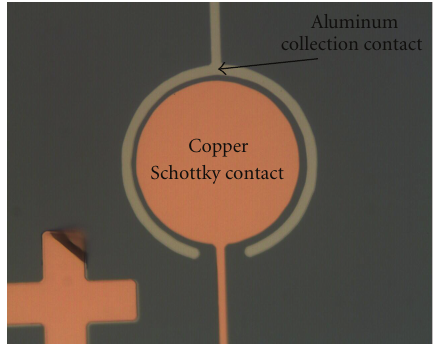
Figure 3: Top view of the proposed fabricated device.